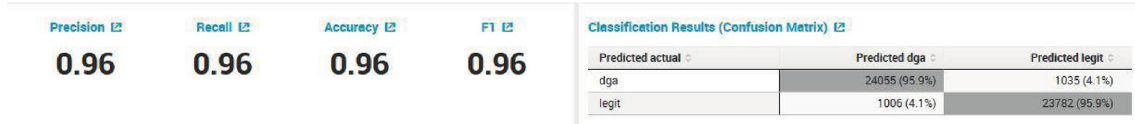
Figure 16: Evaluation of SVM model with feature diagram using principal component analysis feature.